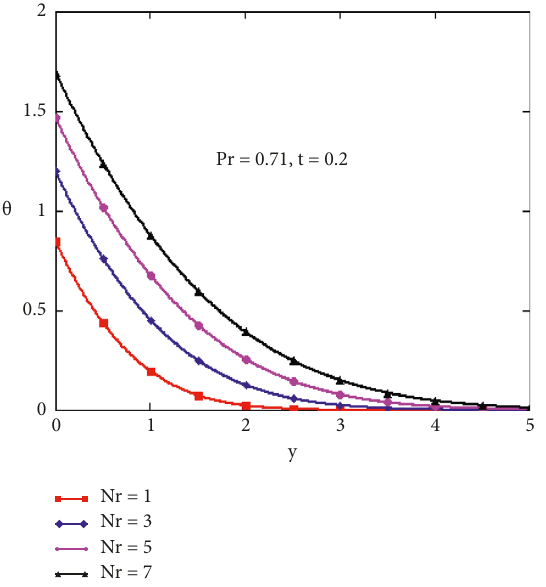
Figure 5: Temperature profile for different values of Nr.